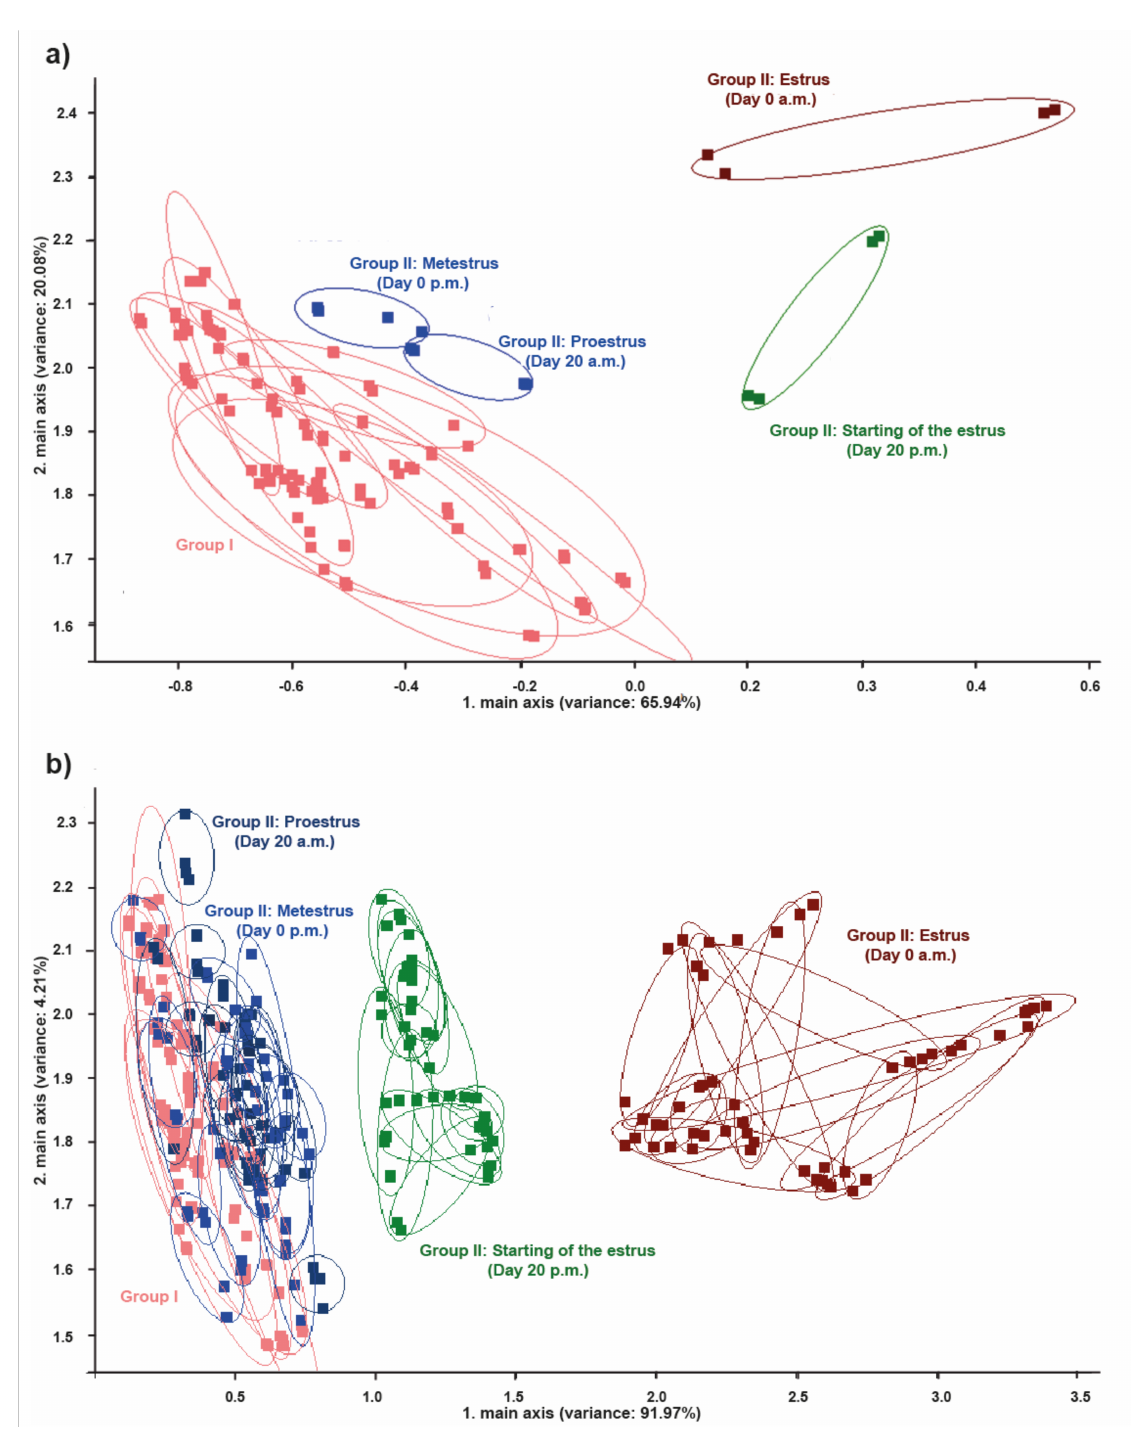
Figure 6. PCA between groups I and II. ( a ) Comparison of PCA between the 10 cows from group I and a cow from group II and ( b ) comparison of PCA between the 10 cows from group I and the 15 cows from group II. Note the low discrimination between the pregnant cows from group I and the regular cycling cow from group II in proestrus (day 20 a.m.) and metestrus (from day 0 p.m.). Note the high discrimination between the pregnant cows from group I and the regular cycling cow from group II in estrus (day 20 p.m. and day 0